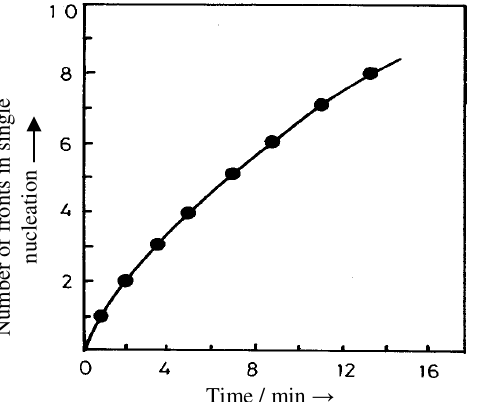
Figure 2 . Number of concentric front nucleated against time. Concentration and conditions are same as in Figure